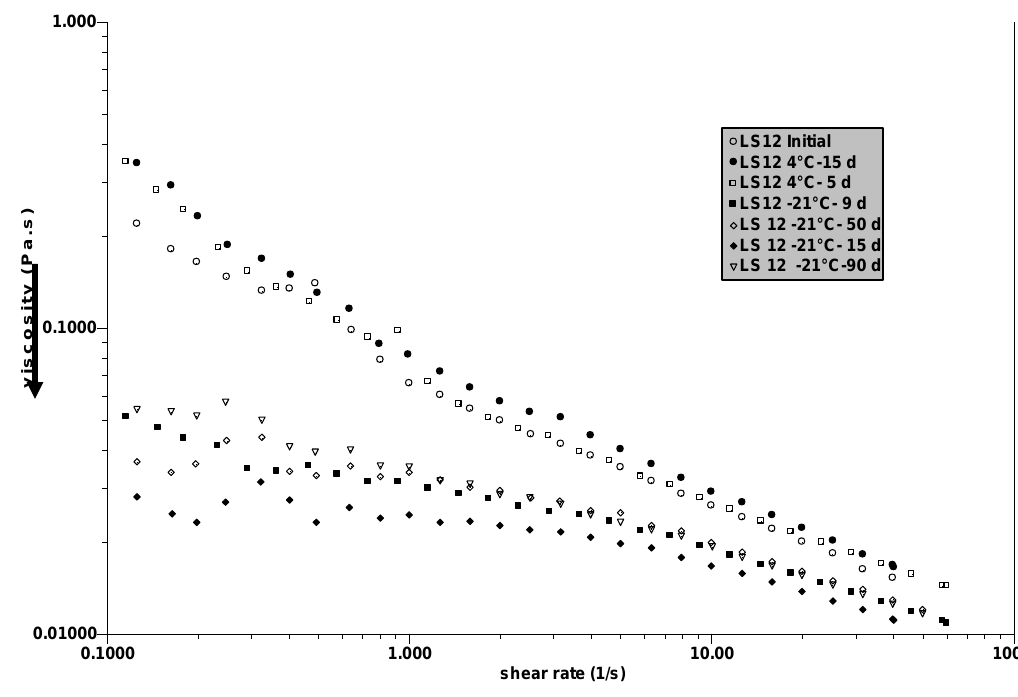
Figure 5. Influence of successive cycles of freezing (at –21 °C) and thawing after different periods of time (in days d) on the SF named LS12. Experiments for storage at 4 °C are joined. Measurements are performed at 25 °C. The arrow indicates the drop in viscosity after the first